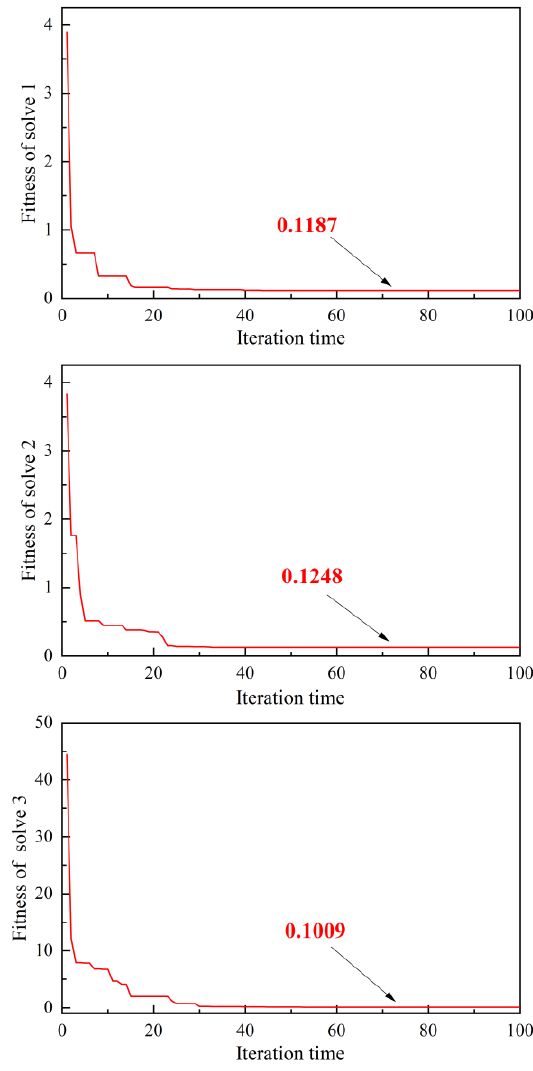
Figure 15. Fitness convergence progress of each solution.